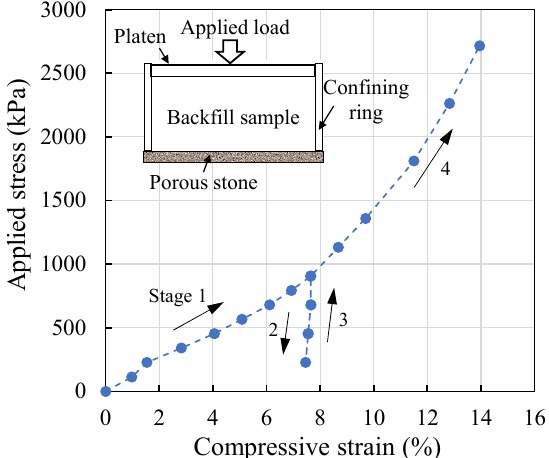
Figure 4. Physical model and stress–strain curve of one-dimensional consolidation tests on Golden Giant paste backfill with a binder content of 3% and a curing time of 28 days conducted by Pierce [26].